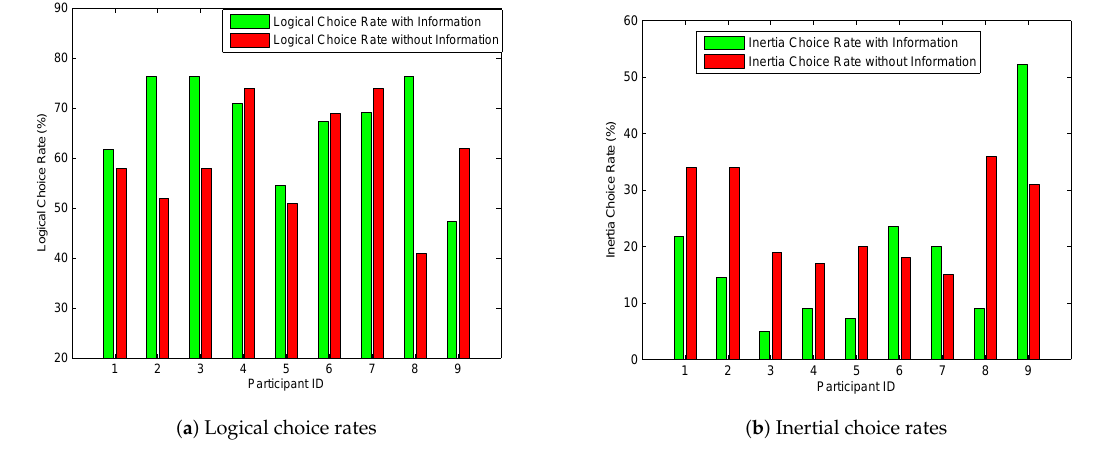
Figure 3. Logical- and inertial- choice rates over participants.